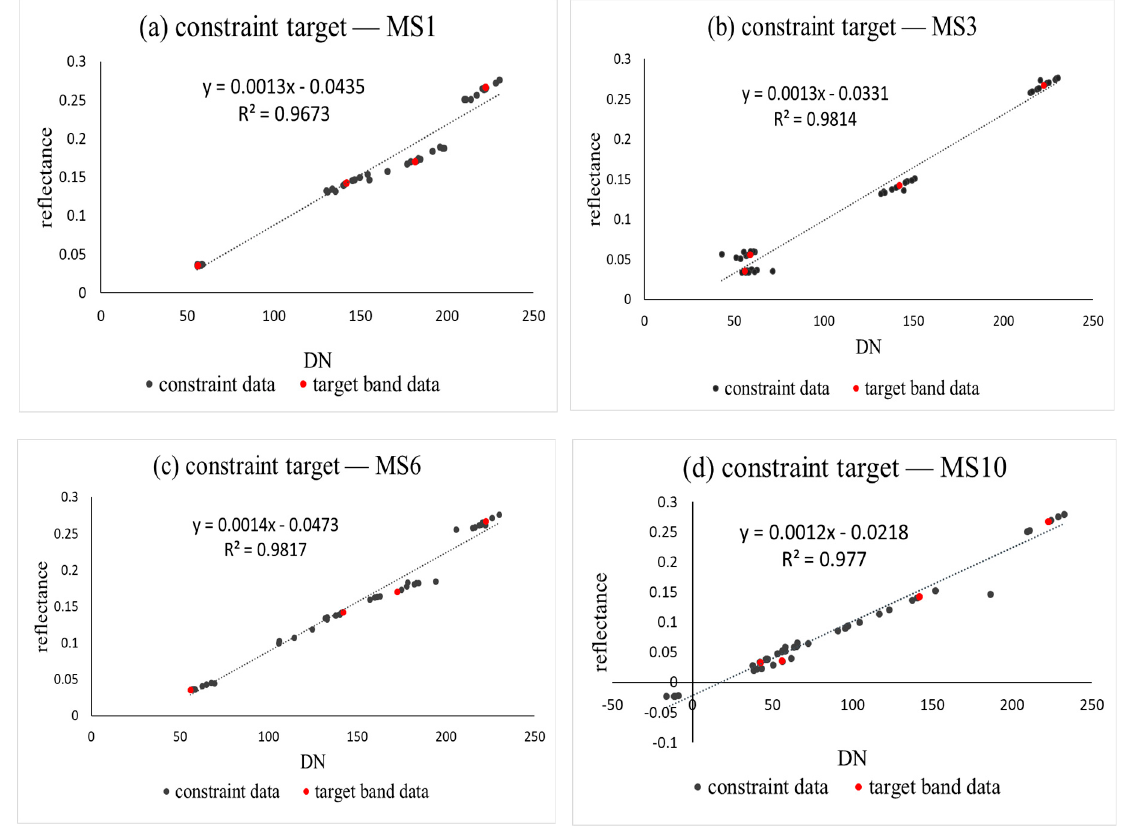
Figure 12. Data generated after constraint modeling of different ground targets. ( a ), ( b ), ( c ) and ( d ) represent the results of constraint modeling with MS1 (brick), MS3 (water), MS6 (floor) and MS10 (vegetation) respectively.